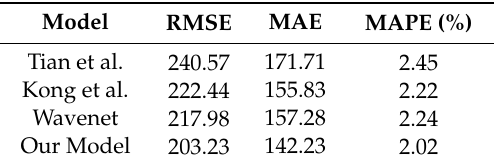
Table 2. Forecasting result obtained using European Network of Transmission System Operators for Electricity (ENTSO-E) testing dataset